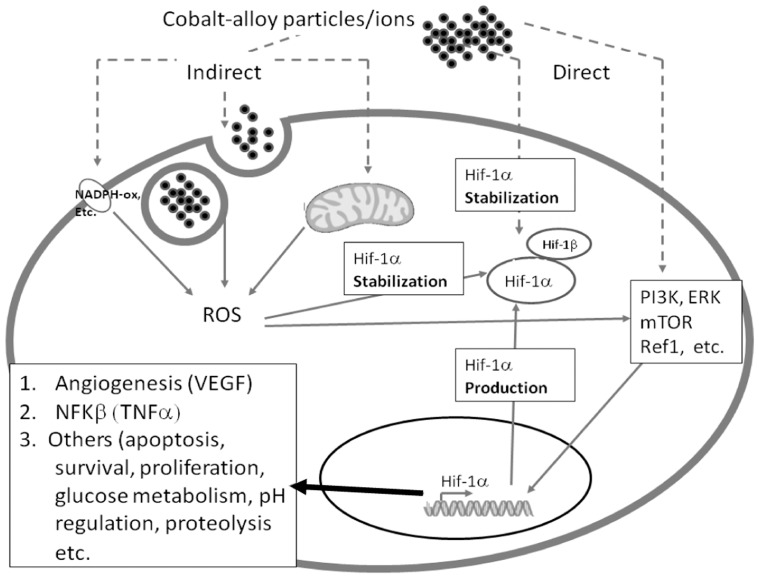
Potential Pathway(s) of HIF-1α Induction to Implant Debris.(A) A representation of how metal implant debris (Co-alloy ions and particles) may lead to induction of HIF-1α activity directly or indirectly given our findings.